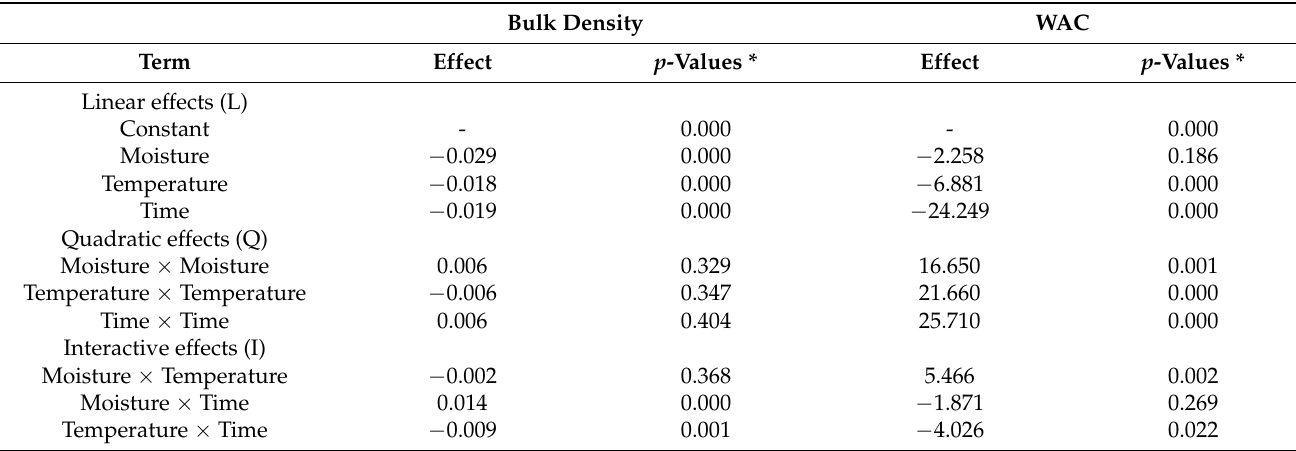
Table 4. CCD (central composite design) regression model fit factor effects for bulk density and water absorption capacity of infrared heated cowpea